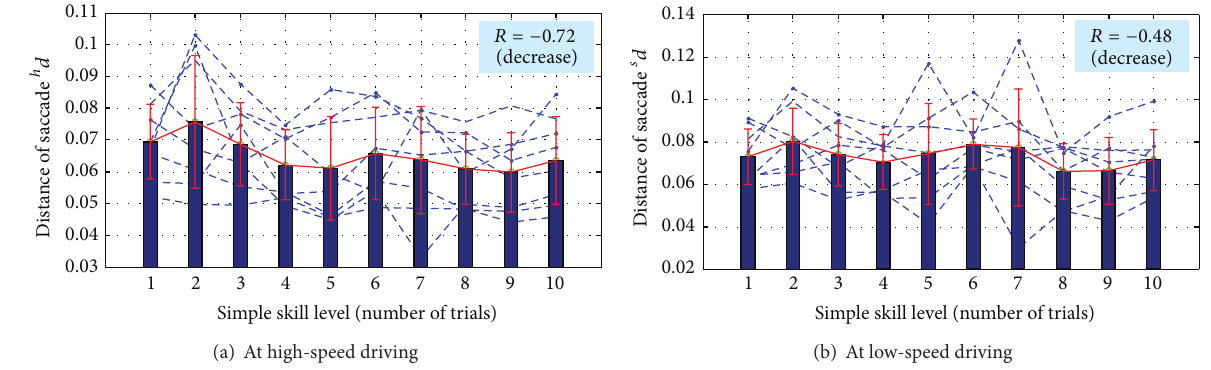
Figure 8: Transition of distance of saccade in a cooperative-carrying